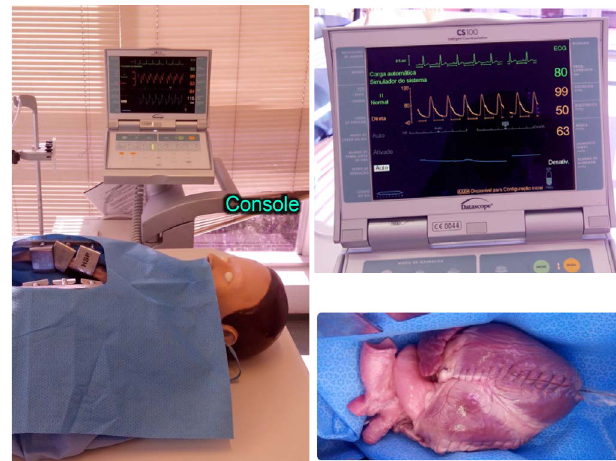
Fig. 9 - The console of intra-aortic balloon pump (Datascope) with the monitor connected to the simulated pulses and positioned aside the